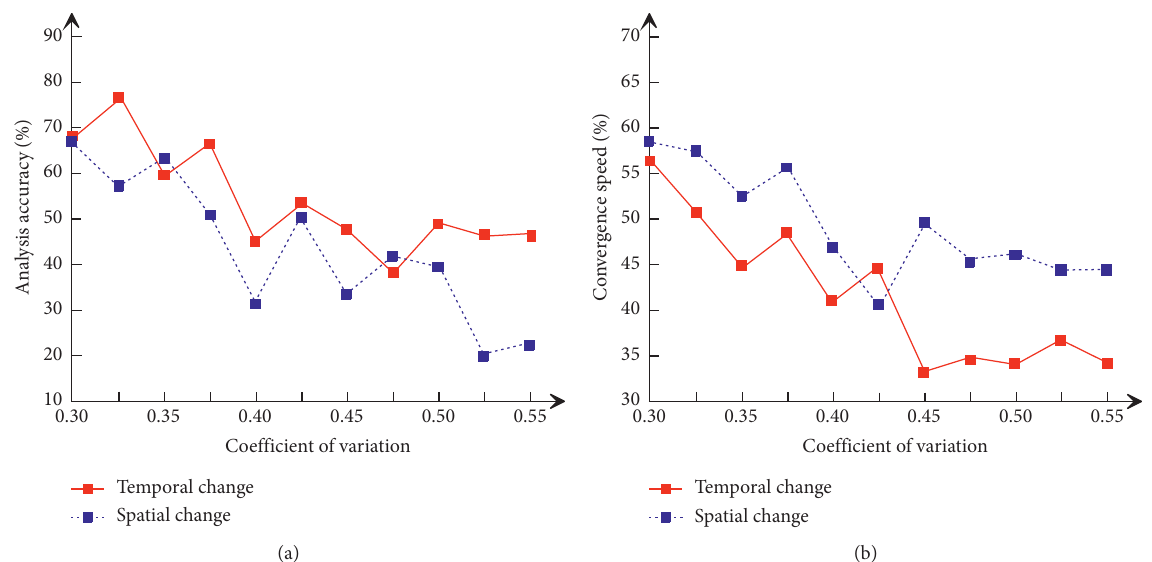
Figure 6: Relationship between coefficient of variation and analysis accuracy and convergence speed in the temporal and spatial regional economic development.